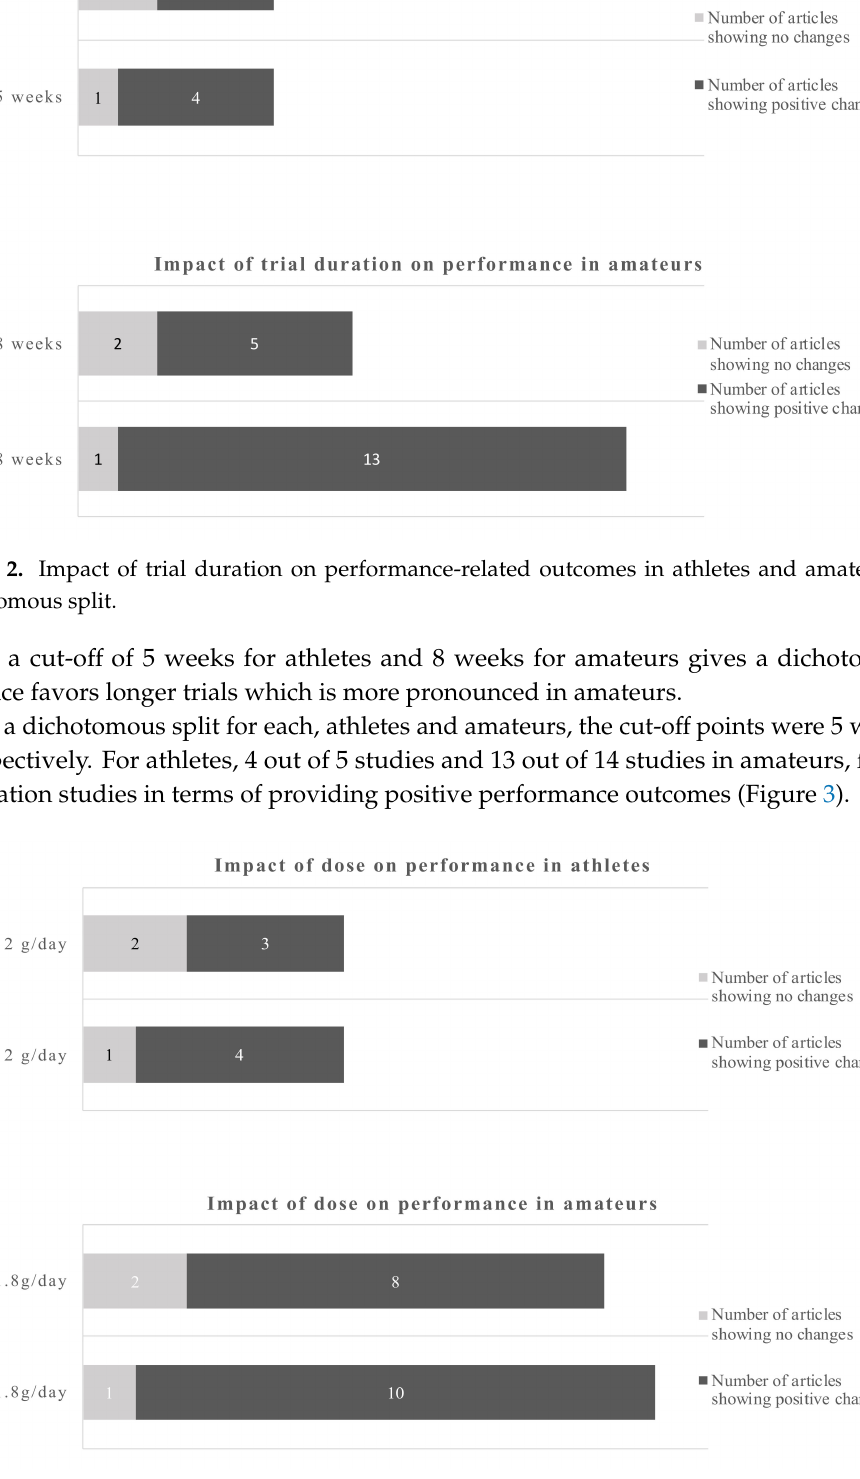
Figure 3. Impact of dose on recovery-related outcomes in athletes and amateurs by dichotomous